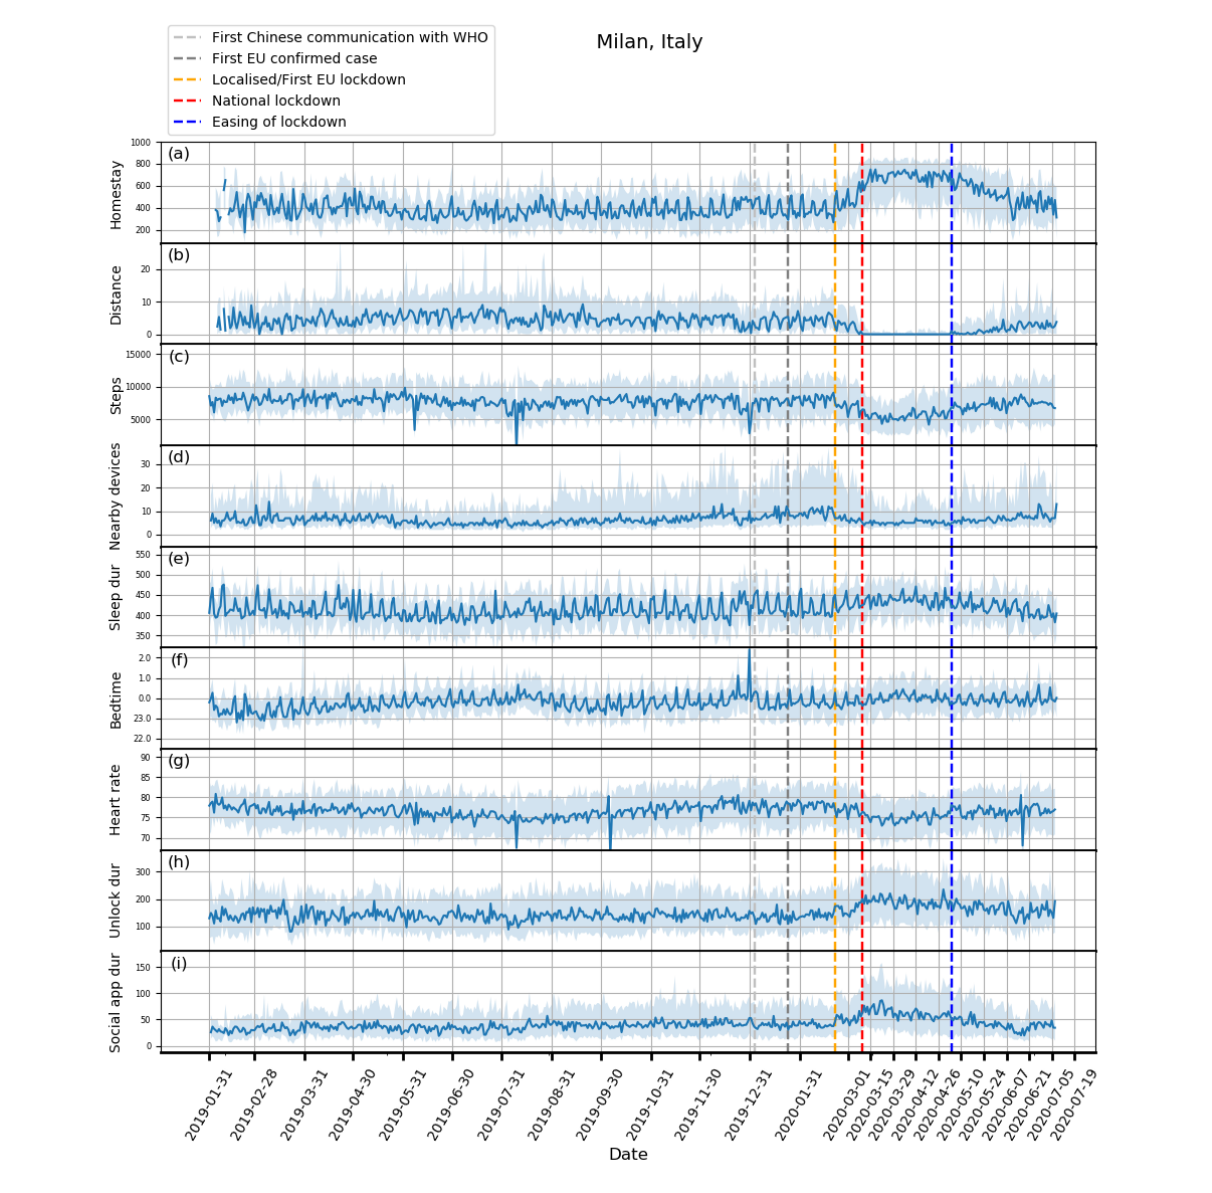
Figure 1. Behavioral changes for Milan, Italy (208 participants). (a) homestay duration, (b) maximum distance from home, (c) Fitbit step count, (d) maximum number of nearby devices, (e) total sleep duration, (f) bedtime, (g) heart rate, (h) unlock duration, (i) social app duration. Solid line: median; shade: 25th percentile to 75th percentile. dur: duration; WHO: World Health